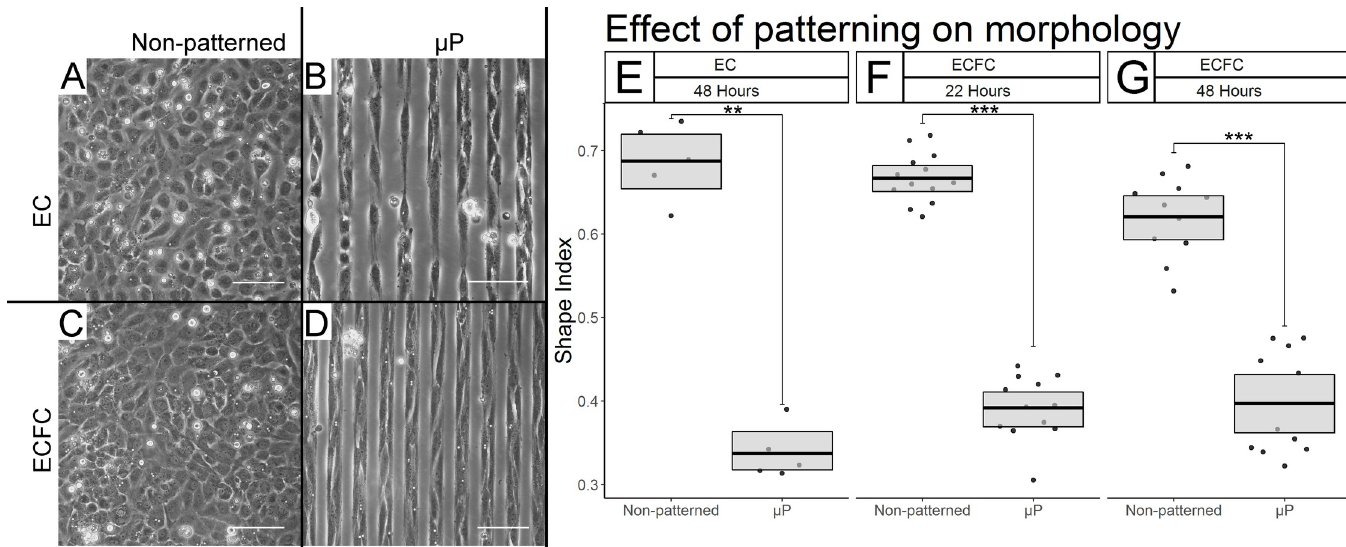
Fig 1. Spatial growth restriction micropatterning effectively growth restricts ECFCs and affects their gross morphology. Representative phase contrast light microscopy after 48 hours of culture at 20X (A-D) reveals effective growth restriction in ECs (B vs. A), and ECFCs (D vs. C) Scale bars = 100 μ m. (E-G) Shape index quantification of EC and ECFC elongation. Box limits represent bootstrapped 95% confidence intervals, and crossbars represent means. Each point represents the mean SI of the 5–10 cells traced from each biological replicate. We find statistically significant micropatterning effects in ECs after 50 hours (E, p = 0.0052), and in ECFCs after 24 (F, p < 0.0001) and 50 hours (G, p < 0.0001).